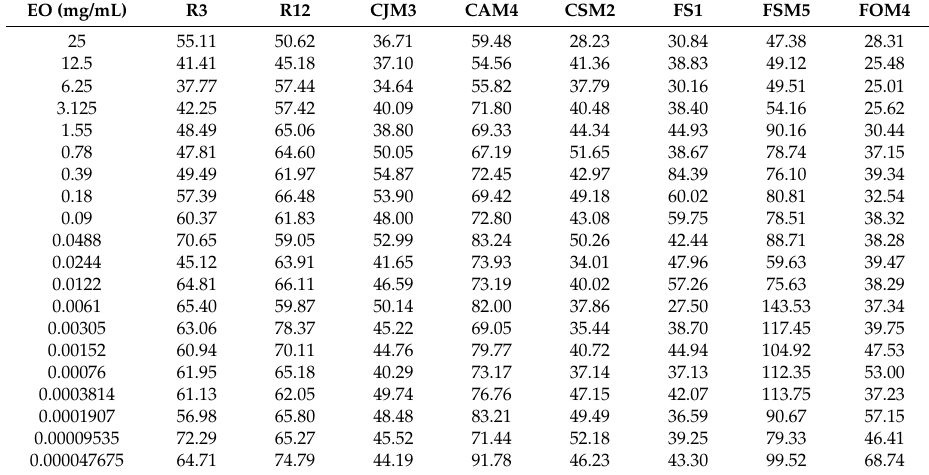
Table 1. Effect of EOs at different concentrations (scalar concentrations starting from 25 mg/mL) on biofilm formation of P. aeruginosa PaO1. Data are reported as percentage of residual biofilm after the treatment in comparison with the untreated one. Each data point is composed of four independent experiments each performed at least in